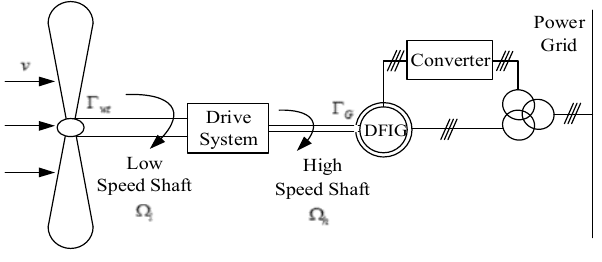
Figure 1. Wind energy conversion system (WECS) based on Doubly fed induction generator (DFIG)